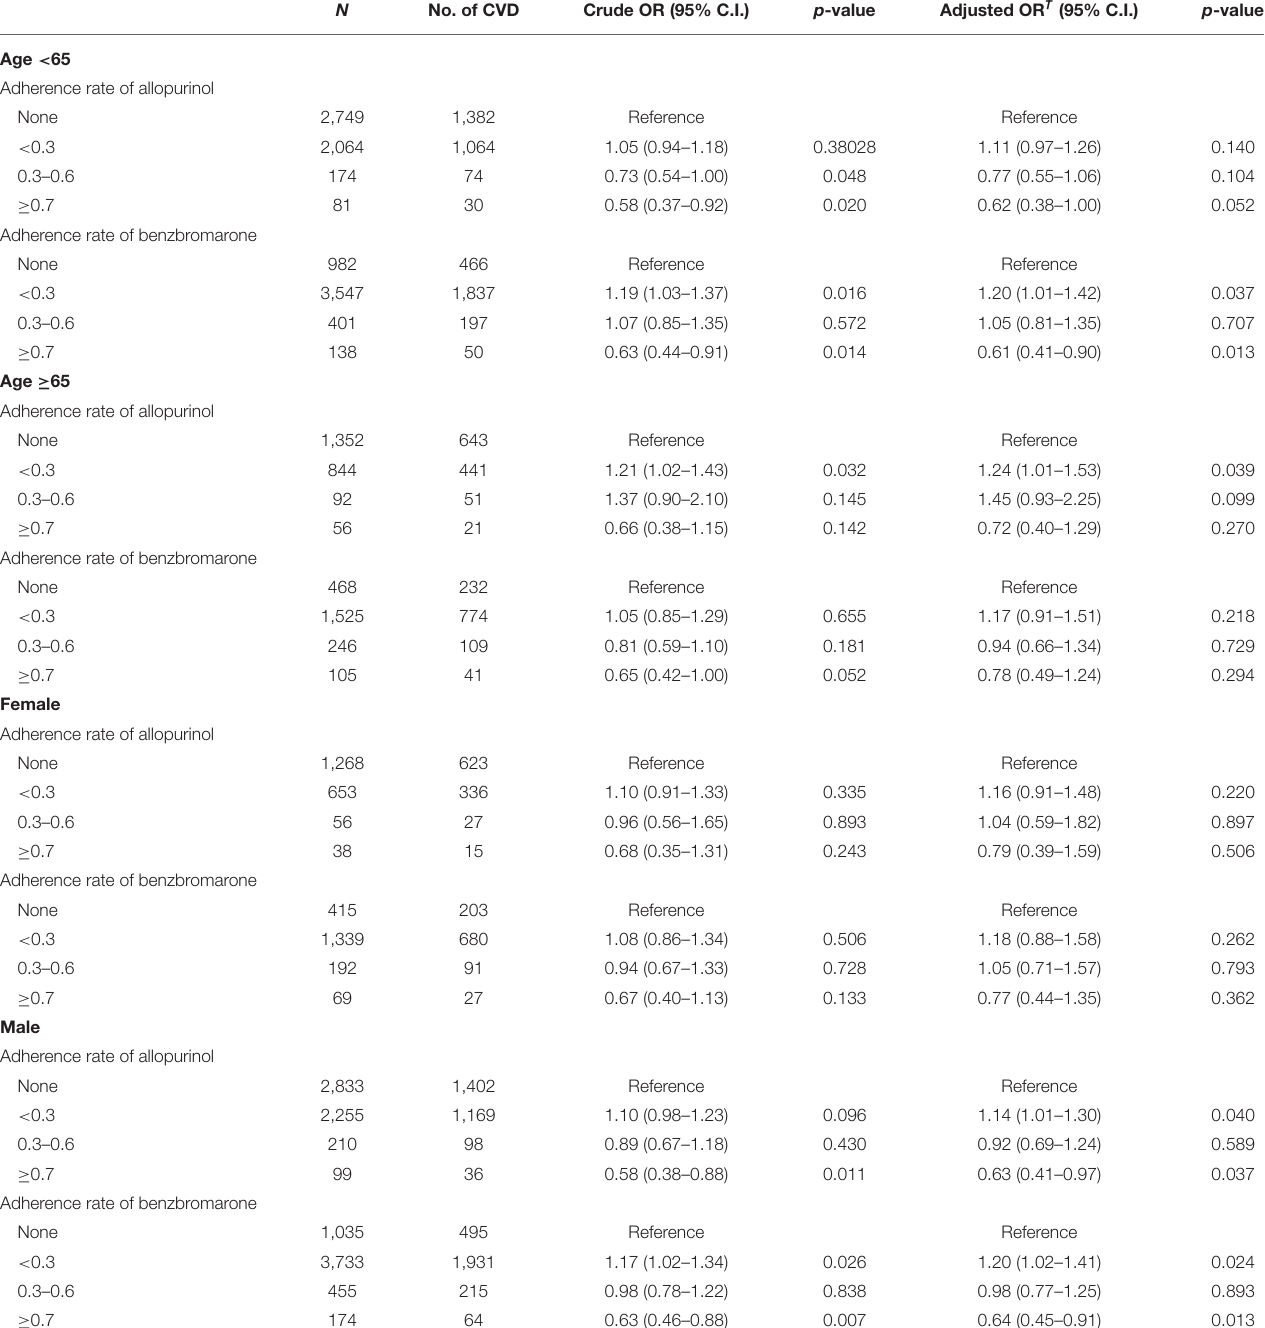
TABLE 4 | Logistic regression of risk of CVD divided by adherence rate of allopurinol and benzbromarone in different age and gender groups. N No. of CVD Crude OR (95% C.I.) p -value Adjusted OR † (95%